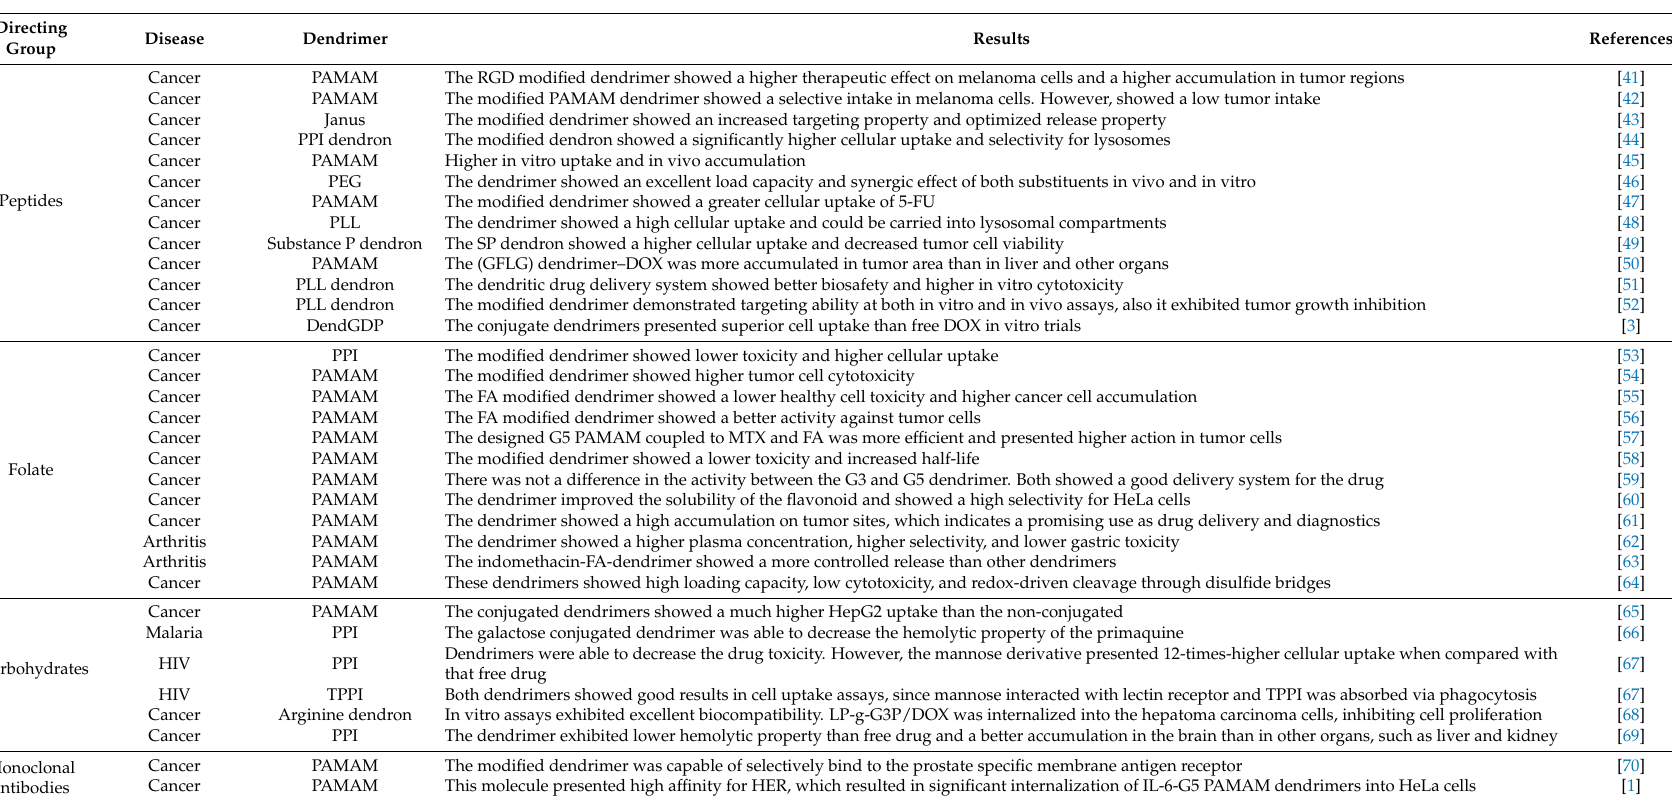
Table 1. Some targeting groups used for dendrons and